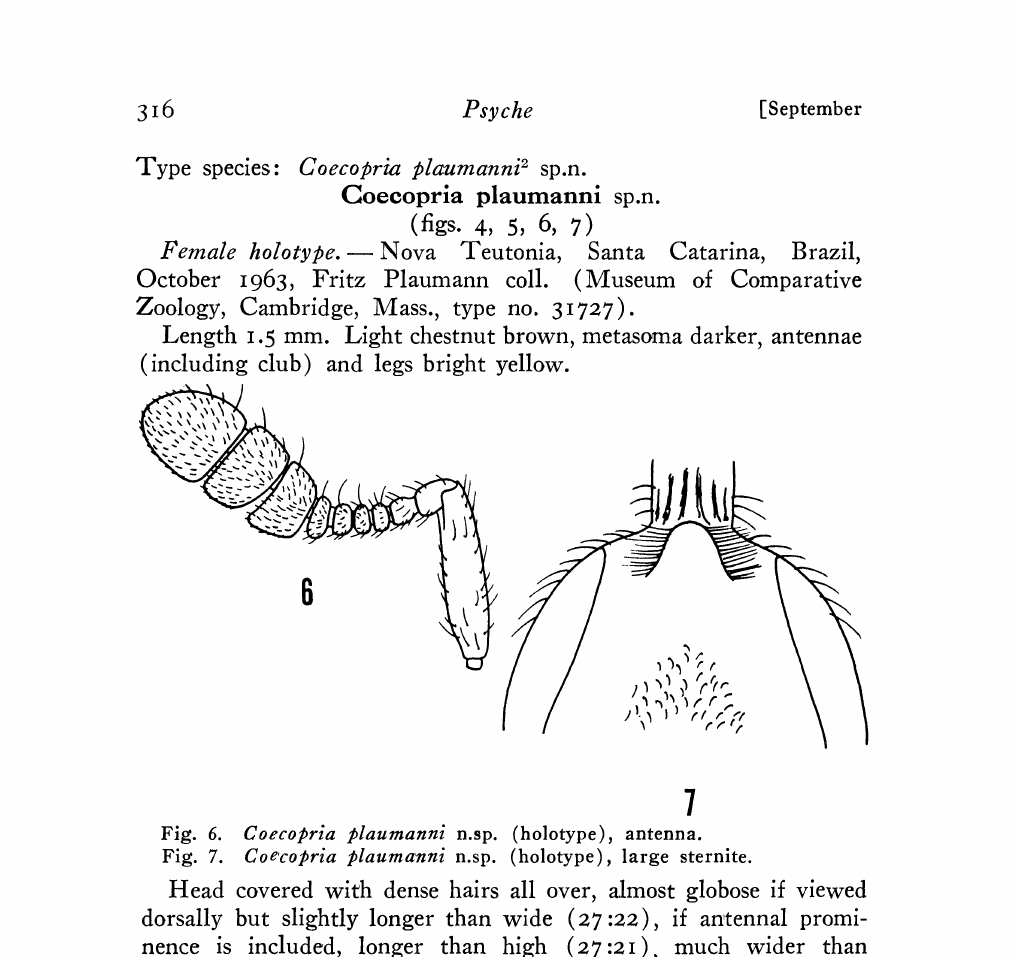
Fig. 6. Coecopria plaumanni n.sp. (holotype), antenna. Fig. 7. Coe’copria plaumanni n.sp. (holotype), large sternite. Head covered with dense hairs all over, almost globose if viewed dorsally but slightly longer than wide (27:22), i an’tennal promi- nence is included, longer than high (27:2I), much wider than mesosoma (22 :I 7) hind genae with little tufts of dense whitish hairs; punctures deep and dense yet not fully contiguous, particularly on occiput; vertex with fine transverse rugulosity; antennae as in fig. 6; scape and pedicel finely